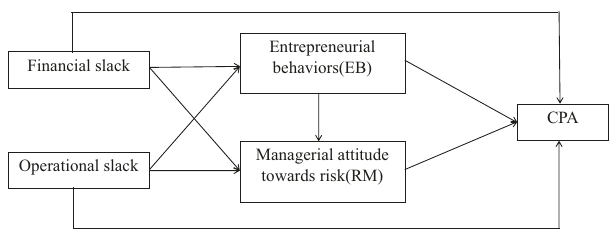
Fig. 1 Research framework of organizational resource and